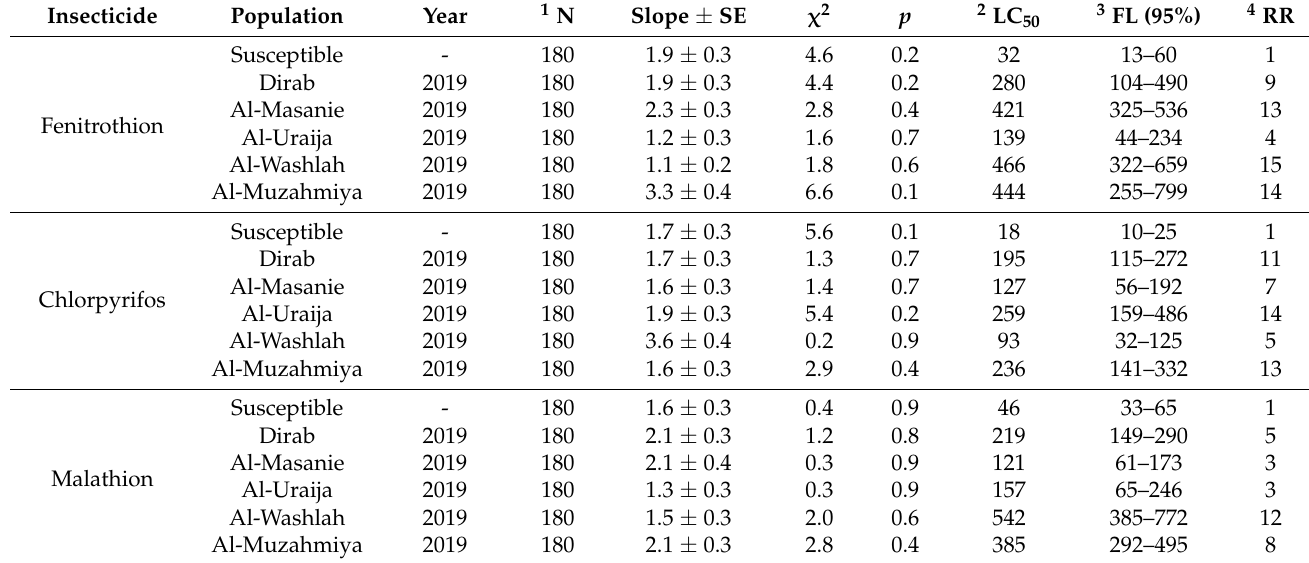
Table 4. Toxicity of organophosphates in adult male house flies from different dairy